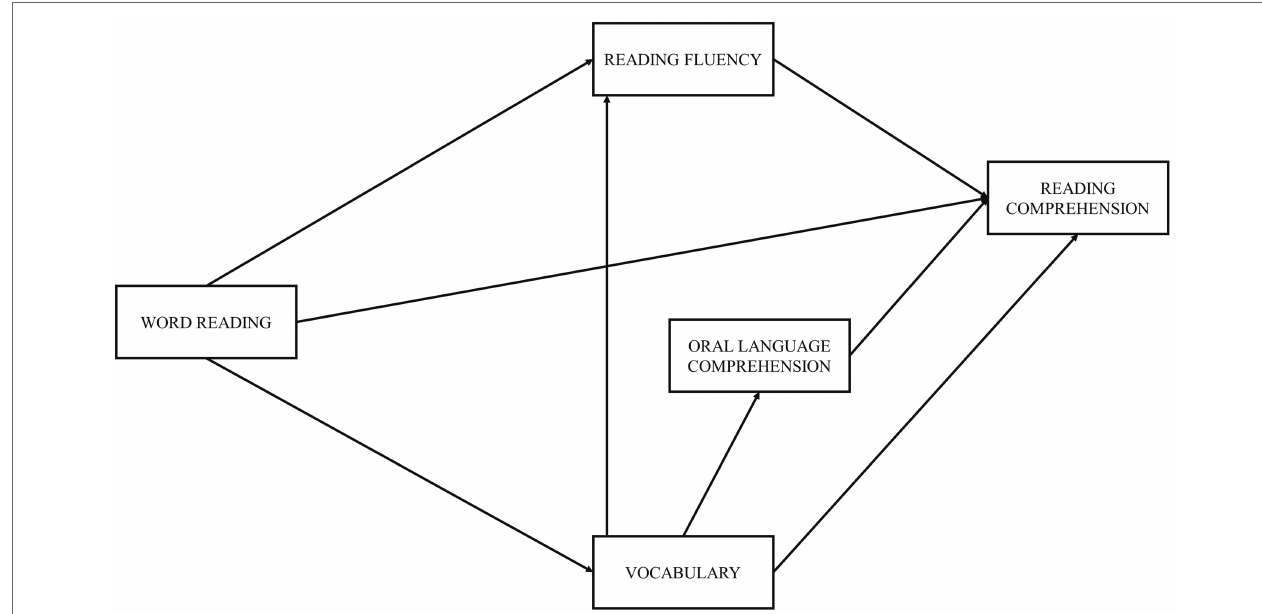
FIGURE 2 | Extended SVR